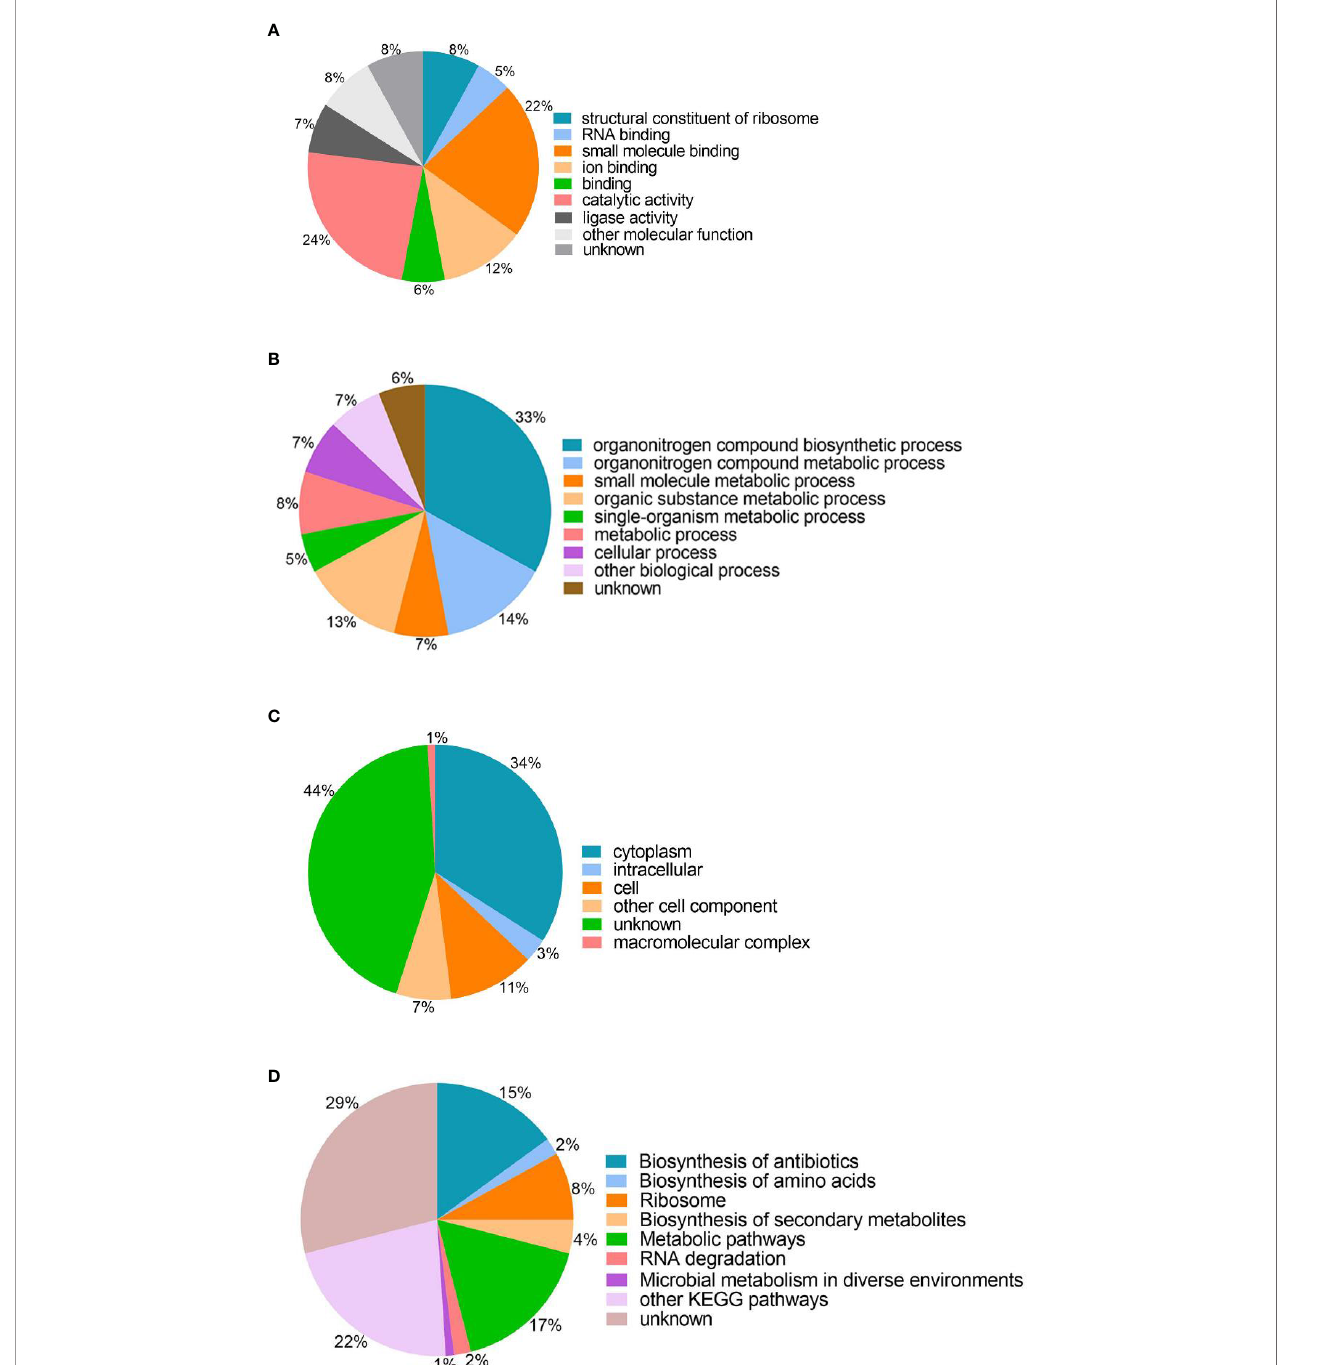
FIGURE 2 | Gene ontology functional classi fi cation and KEGG pathway analysis of the identi fi ed succinylated proteins. (A) Molecular function. (B) Biological processes. (C) Cell components. (D) KEGG pathway